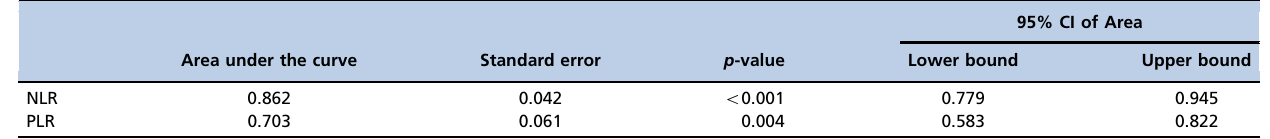
Table 4 - ROC curves of NLR and PLR for predicting